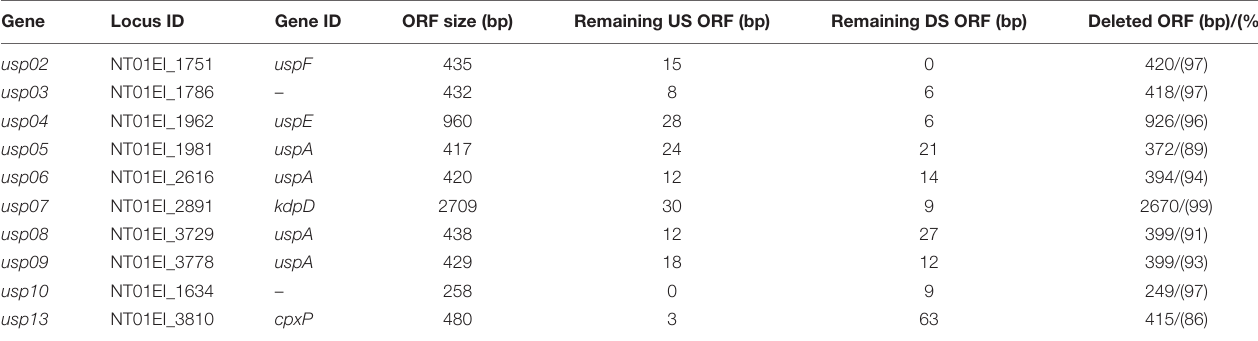
TABLE 3 | Summary of E. ictaluri usp genes and in-frame deletion.